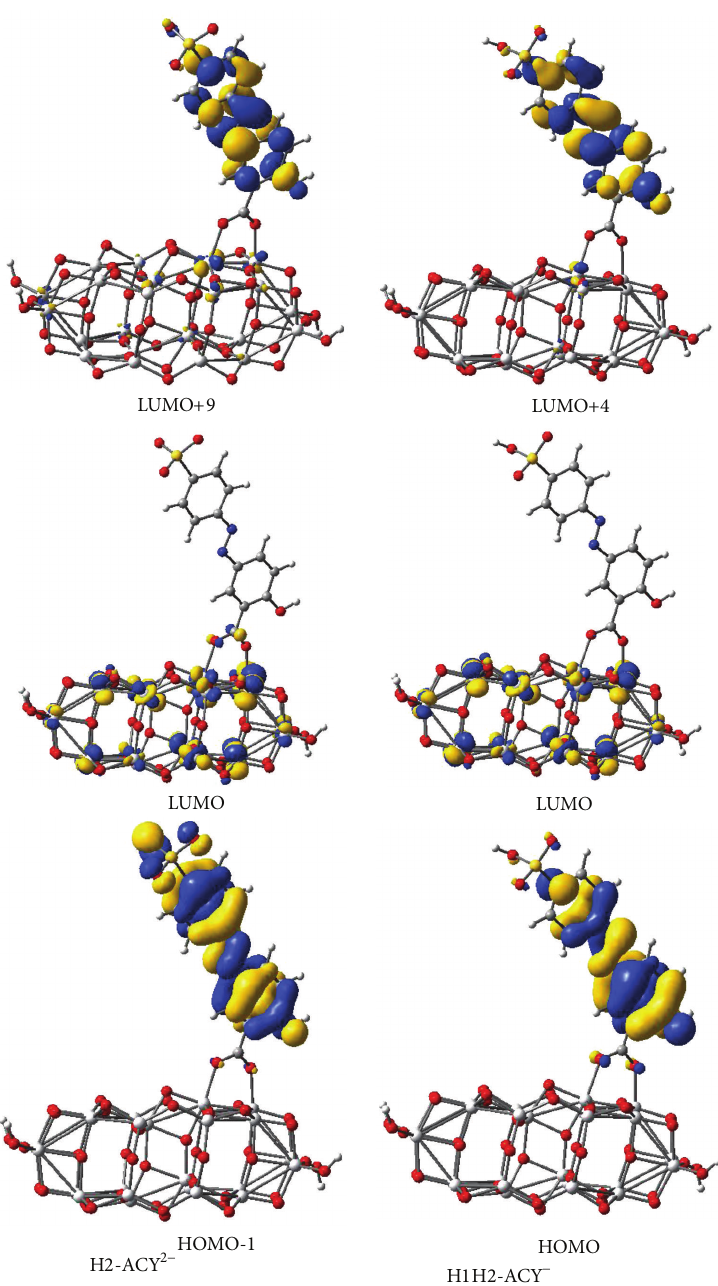
Figure 11: Isodensity surfaces (0.03e/bohr 3 ) of the key molecular orbitals of the dyes adsorbed on the TiO 2 nanocluster calculated at DFT/B3LYP/DZVP level in